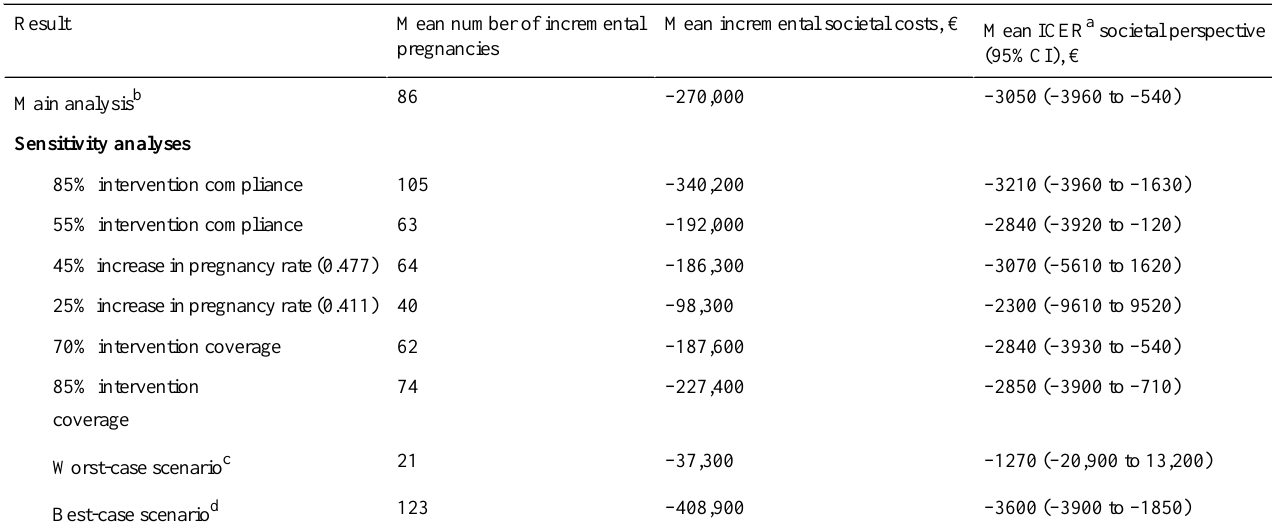
Table 2. Results of the sensitivity